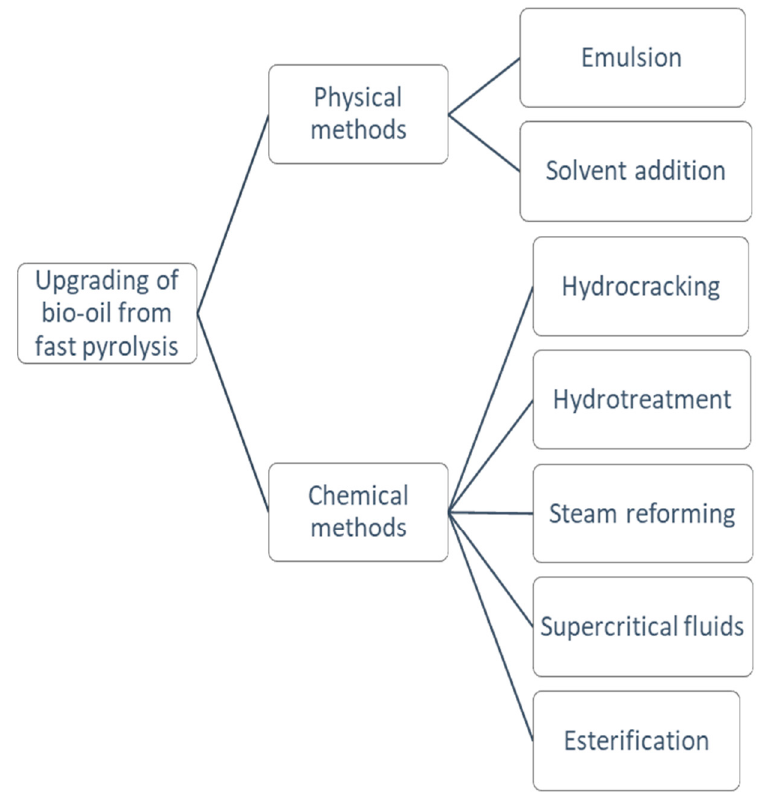
Figure 2. The major upgrading approaches applied for the bio-oil obtained from fast pyrolysis [29].